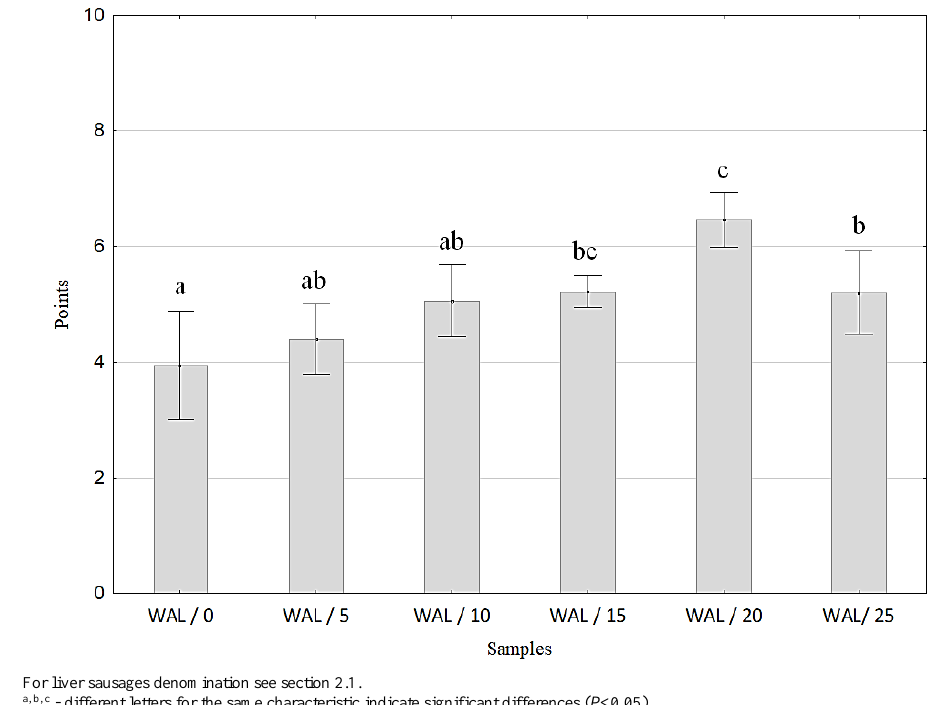
Figure 4. Overall desirability of liver sausages, n = 4.